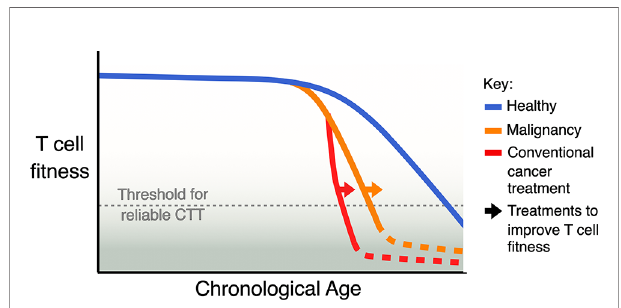
FIGURE 2 | Model of the cumulative impact of ageing, malignancy, and conventional treatment for cancer on T cell fi tness. Natural ageing leads to a decline in T cell fi tness, malignancy accelerates this decline and some conventional cancer therapies, especially ASCT, can further accelerate this decline. A key aim for improving CTT should be to identify strategies and treatments that can avoid or revert the loss of T cell